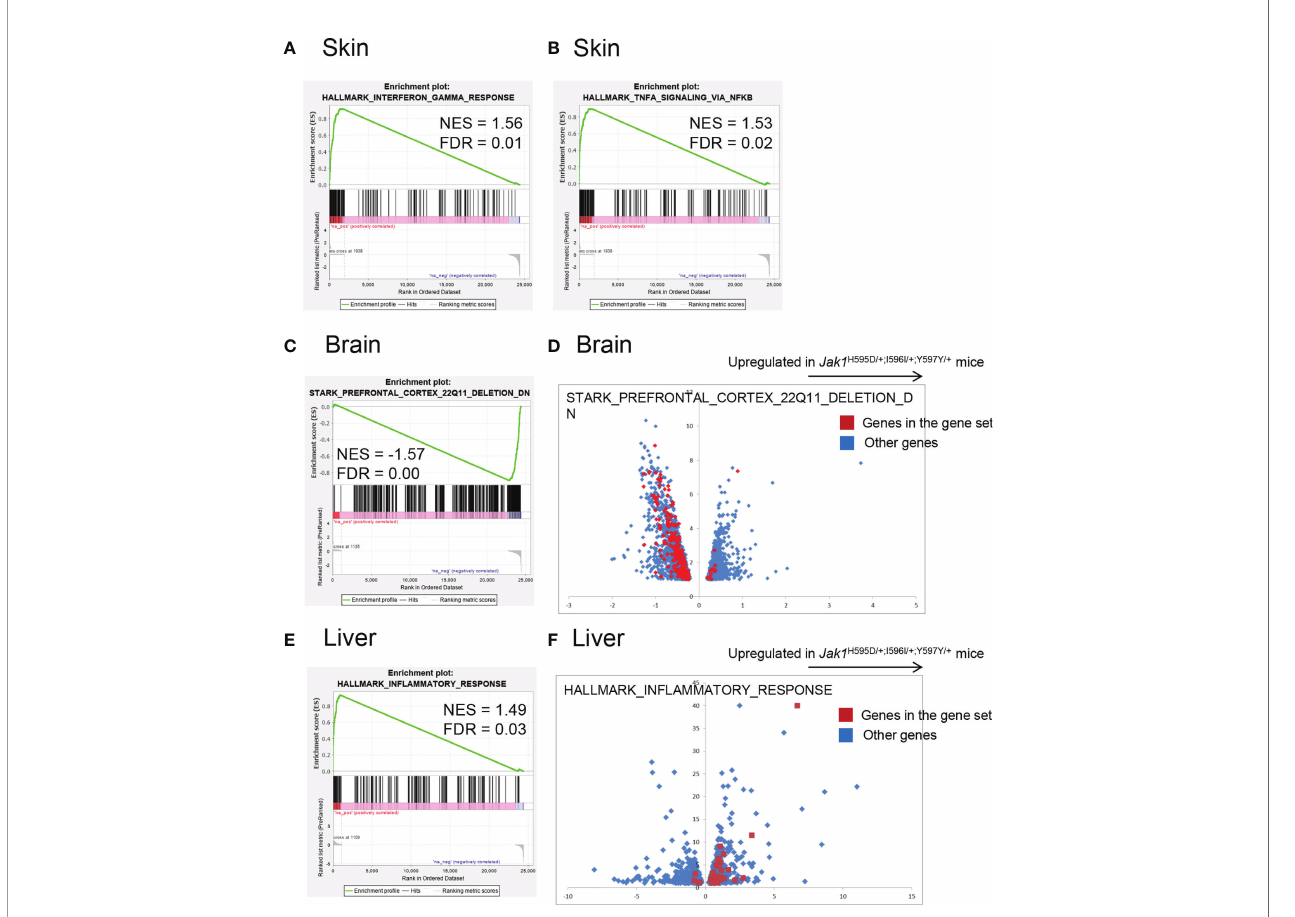
FIGURE 3 | Global gene expression pro fi ling of the RNA samples in Jak1 H595D/+;I596I/+;Y597Y/+ mice. Gene set enrichment analysis using the hallmark gene set database. (A, B) Skin. Genes associated with HALLMARK_INTERFERON_GAMMA_RESPONSE (A) and HALLMARK_TNFA_SIGNALING_VIA_NFKB (B) are relatively upregulated in skin samples from the Jak1 H595D/+;I596I/+;Y597Y/+ mice. (C, D) Brain. Genes associated with STARK_PREFRONTAL_CORTEX_22Q11_ DELETION_DN are downregulated in brain samples from the Jak1 H595D/+;I596I/+;Y597Y/+ mice. The red dots in (D) indicate genes in this gene set. Blue dots: the other genes. (E, F) Liver. Genes associated with HALLMARK_INTERFERON_GAMMA_RESPONSE are upregulated in liver samples from the Jak1 H595D/+;I596I/+;Y597Y/+ mice. The red dots in (F) indicate genes in this gene set. Blue dots: the other genes. NES, normalized enrichment score; FDR, false discovery